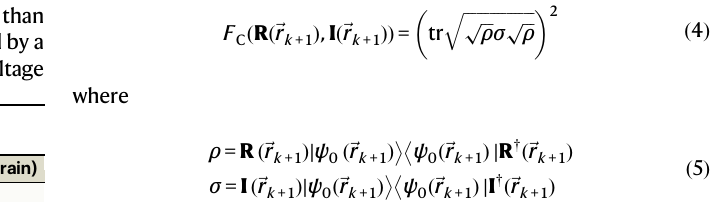
Fig. 2 | Electric and strain fi eld pro fi les. a Electric fi eld component ∣ ~ E ? ð x , y =0, z Þ ∣ for a applied voltage V k on a single pair of electrodes. b ∣ ~ E ? ð x , y =0, z Þ ∣ for voltage settings optimized for reduced cross-talk. c Electric fi eld component ∣ ~ E ∣ along central axis of the FPSA (dotted line in a ) for the voltages ? ð x , y = z =0 Þ con fi gurationswithandwithoutcrosstalkelimination(CE),andcorrespondingRabi